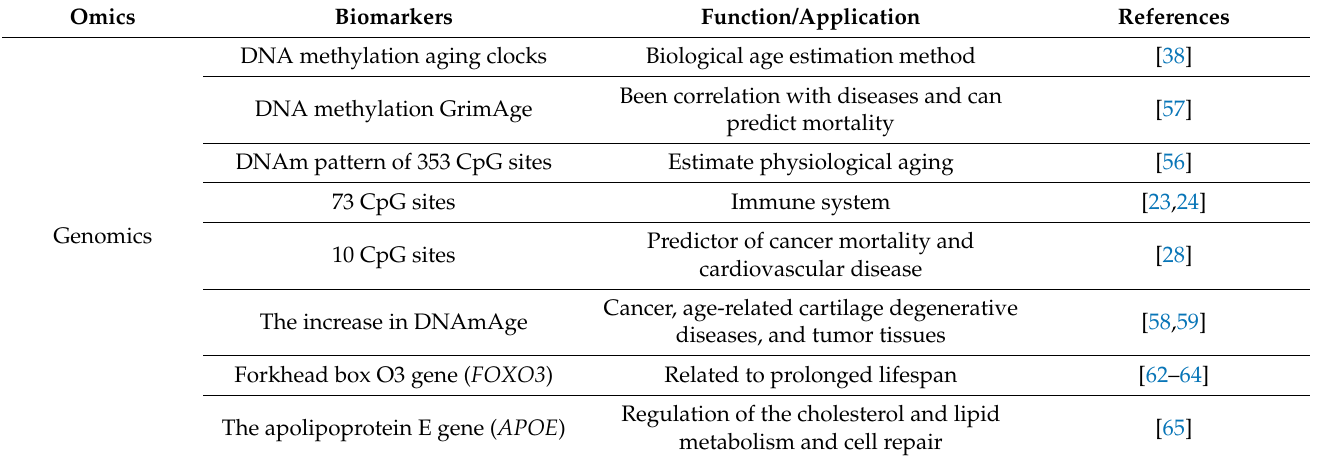
Table 1. Potential aging biomarkers identified in genomics